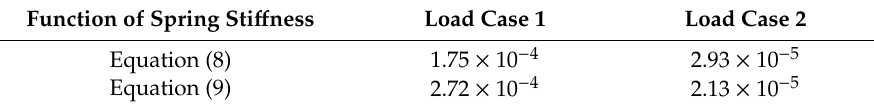
Figure 8. Time course of vertical displacement of point C: ( a ) load case 1 and function (8), ( b ) load case 2 and function (8), ( c ) load case 1 and function (9), ( d ) load case 2 and function (9). FEM, finite element method. Table 1. Mean-squared errors of vertical displacement of point C (mm 2 ).